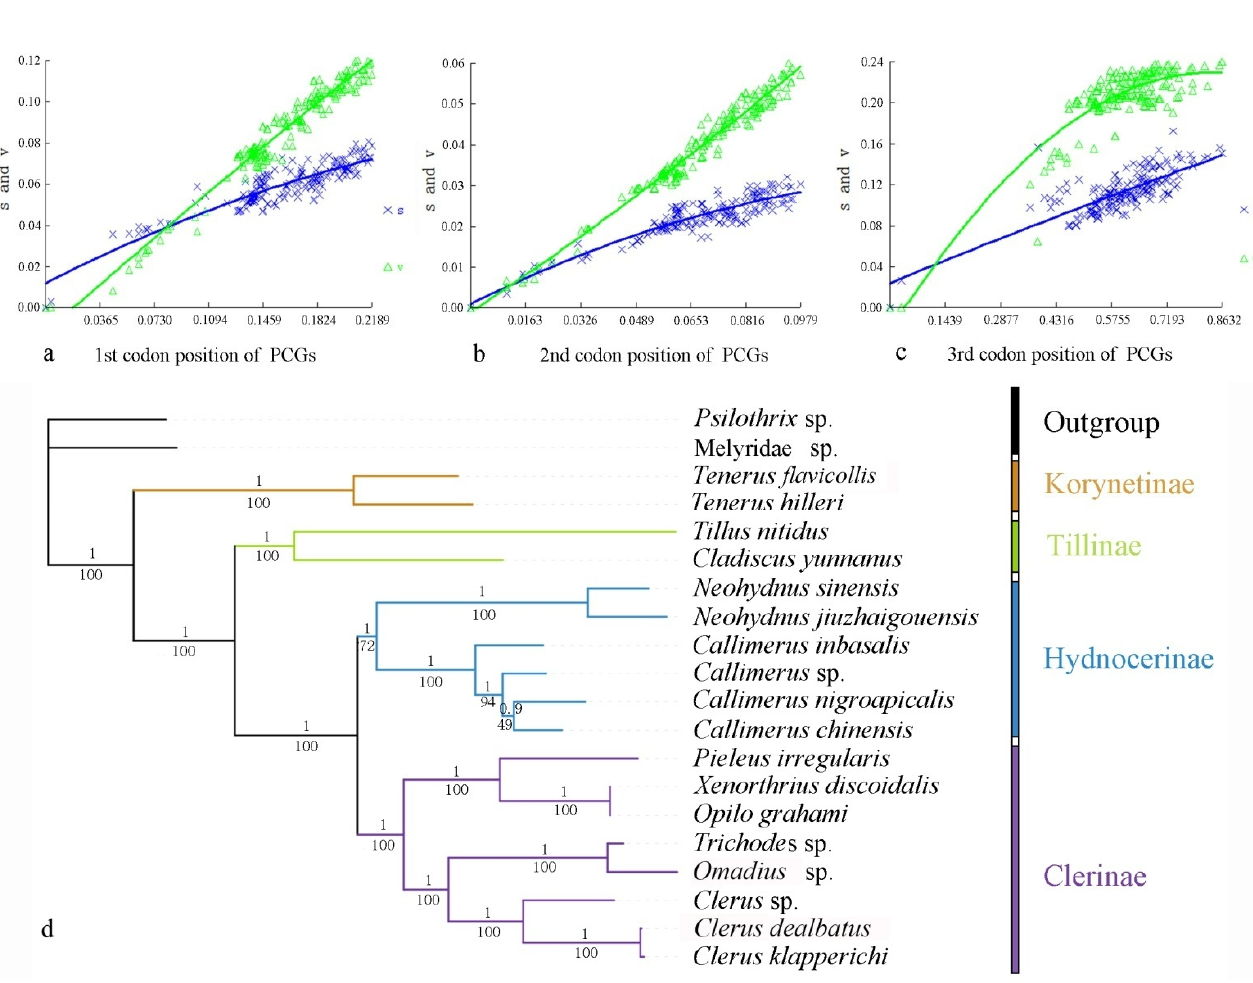
Figure 2. Nucleotide substitution saturation plots of all mitochondrial protein-coding genes: ( a ) 1st codon positions; ( b ) second codon positions; ( c ) third codon positions. Plots in blue and green indicate transition and transversion, respectively; ( d ) phylogenetic tree of Cleridae inferred from the BI and ML analyses of the PCG12RNAdataset. Numbers at the branches determine posterior probability (upper) or bootstrap value (lower).